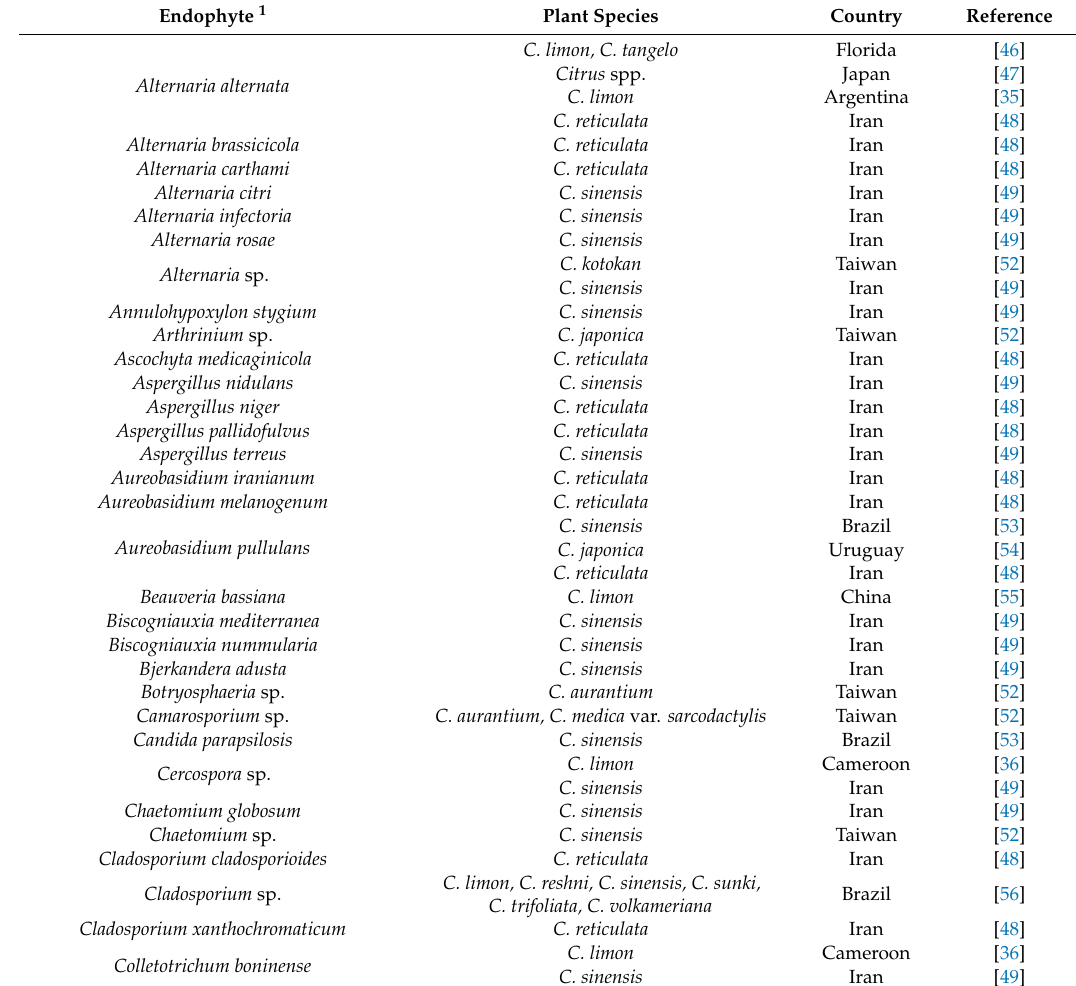
Table 1. Endophytic fungi reported from Citrus